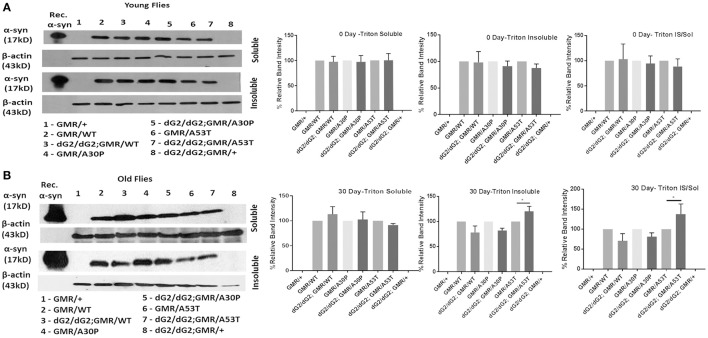
Triton-soluble and triton-insoluble α-syn level in dG2/dG2 RNAi flies expressing WT, A30P, and A53T synuclein. Western blot of triton-soluble and insoluble fraction of 0 day (A) and 30 day (B) old fly head lysates probed for α-syn showed increase in triton-insoluble α-syn levels in dG2/dG2 A53Tmutant flies compared to corresponding A53T control flies at 30days. In the corresponding densitometric analysis, controls (GMR with/without α-syn) are normalized to 100% and experimental flies (dG2/dG2 with/without α-syn) are compared against their respective controls. Triton-Insoluble α-syn was also normalized to corresponding triton-soluble α-syn. Graph represents mean ± S.E.M. for 3 independent experiments. Differences in means were compared by one-way ANOVA followed by the Newman-Keuls Multiple Comparison post hoc test. * represents p < 0.05.